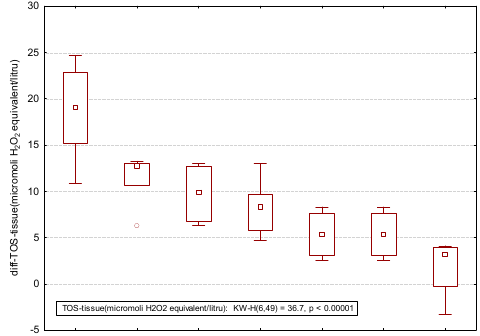
Figure 10. Differences relative to the control (no myocardial infarction, C group) of antioxidant capacity in the myocardial tissue: Thiol and total antioxidant capacity (TAC) by groups and of oxidative stress intensity in the myocardial tissue: nitric oxide (NOx), malondialdehyde (MDA), and total oxidative status (TOS) by groups. MI-C = isoproterenol without any pre-treatment; Cs = curcumin solution, in doses of 100 mg/kg bw (Cs100), 150 mg/kg bw (Cs150), and 200 mg/kg bw (Cs200); nC = curcumin nanoparticle solution, in doses of 100 mg/kg bw (nC100), 150 mg/kg bw (nC150), and 200 mg/kg bw (nC200). * extreme value; outlier